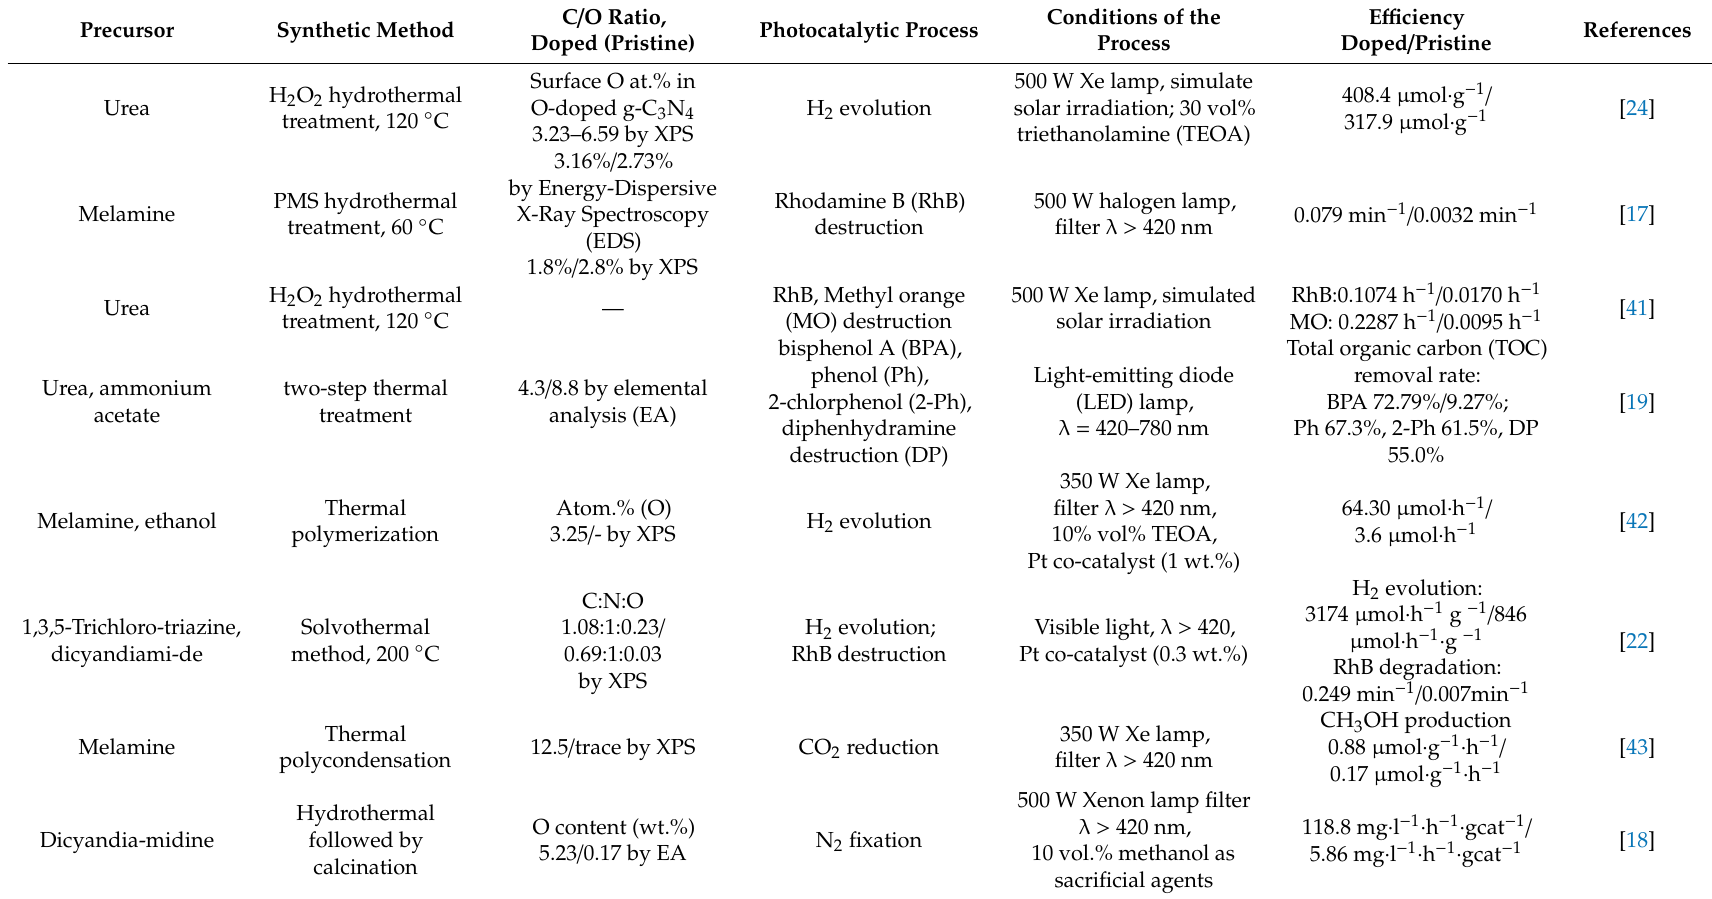
Table 1. Synthetic methods, applications, and photocatalytic e ffi ciency of O-doped g-C 3 N 4